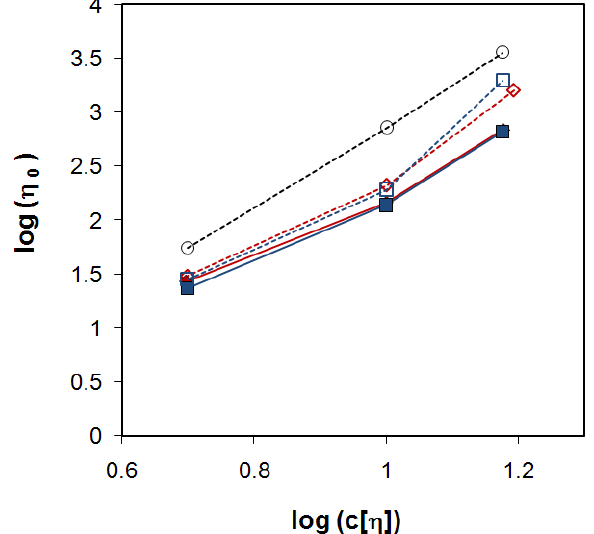
Figure 7 . Zero shear viscosity plotted against the reduced concentration on a log-log scale for PEO 0.3 (filled red diamonds), PEO 80:20 (open red diamonds), dextran 500 (filled blue squares) and dextran 50:50 (open blue squares). Since no Newtonian plateau was found for HPMC 60SH 90:10 the viscosity at 1 s -1 is included in the plot for comparison. (open grey